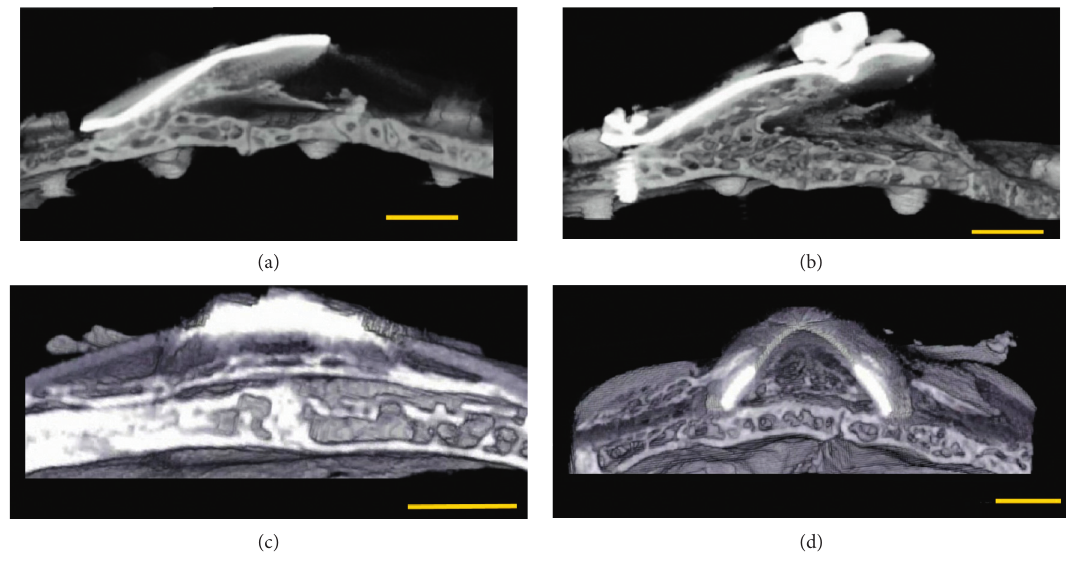
Figure 4: Longitudinal microradiograph section of activated expansible guided bone regeneration (EGBR) and smart guided bone re- generation (SGBR) devices at the 2- and 4-month time points. (a) The EGBR device at the 2-month time point where one side is elevated, and new bone is formed in the space below, atop of the original bone surface. (b) The EGBR device at the 4-month time point shows almost the same microradiographical picture as at the 2-month time point; however, the bone is more abundant. (c) The SGBR device at the 2-month time point where a new layer of bone is formed above the original bone below the silicone sheet. (d) The SGBR device at the 4-month time point shows a similar picture with more abundant bone formation. Scale bar � Table 1: Space, bone volumes, and bone height values for each device at 2 and 4 months. 2 months 4 months